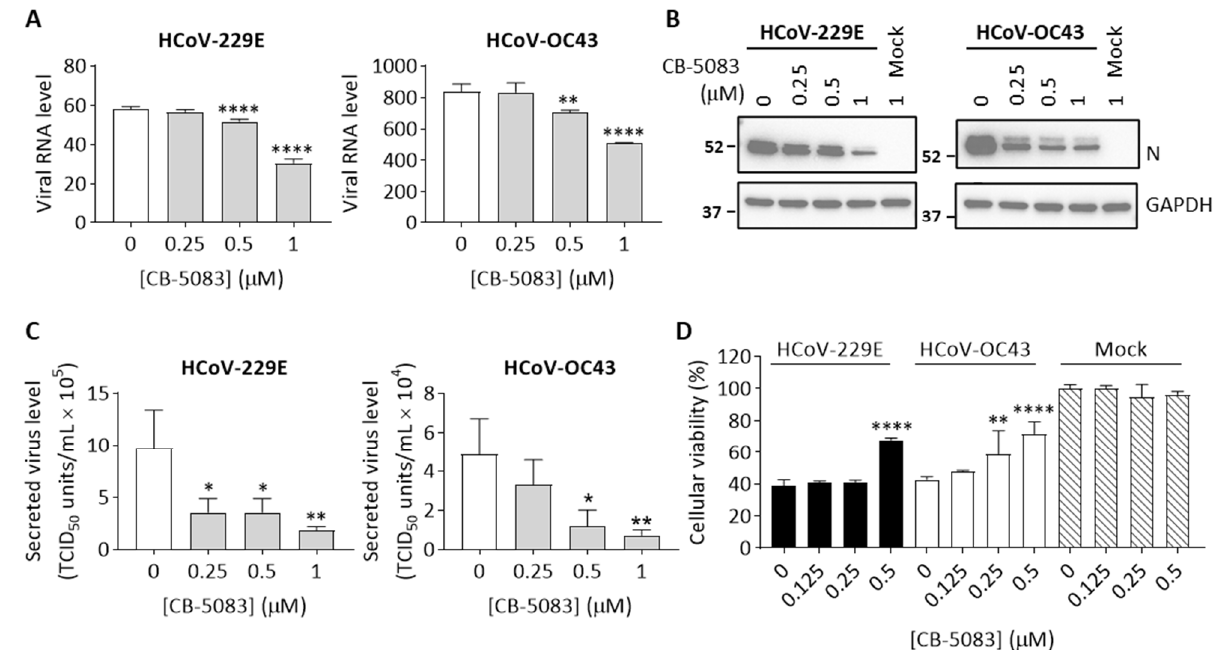
Figure 2. p97 inhibition by CB-5083 suppresses HCoV replication in H1299 cells. H1299 cells were infected with HCoV-229 (MOI 0.5), HCoV-OC43 (0.01), or mock-treated in the presence of CB-5083 at the indicated concentration. Cultured media containing CB-5083 was removed at 8 hpi and replaced with fresh media without CB-5083. ( A ) Cells were harvested to quantify viral RNA levels in cell lysates at 24 hpi. Data shows viral RNA levels relative to GAPDH. ( B ) Representative Western blot analysis of the expression viral N protein and GAPDH (loading control) in cells treated with CB-5083 at 24 hpi after HCoV or mock infection. Full-length blots are included in Supplementary Figure S3 ( C ) Titer of secreted virus in culture media collected from the HCoV-infected cells at 24 hpi was quantified by determining TCID 50 in H1299 cells. ( D ) Cellular viability of infected cells was determined at 72 hpi and normalized to mock-infected and DMSO-treated controls. All conditions were performed in biological triplicate. Error bars represent SD ( n = 3). Statistical analysis was conducted with one-way ANOVA compared to infected control (0 μ M of CB-5083): *, p < 0.05; **, p < 0.01; ****, p < 0.0001.